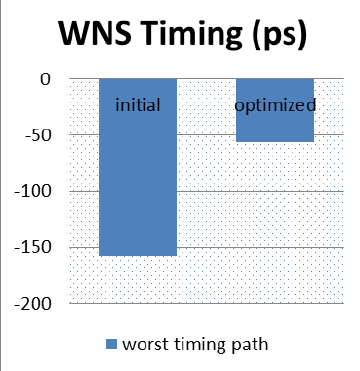
Figure 14 . Worst negative slack (WNS) optimization.